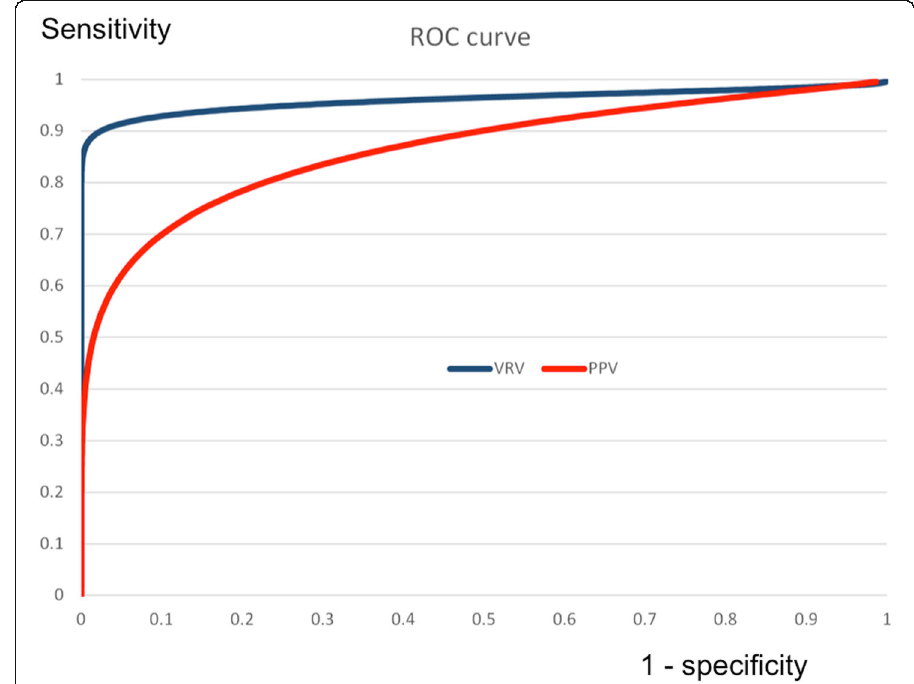
Fig. 5 AUC curves for VRV (0.96) and PPV (0.85) for prediction of fluid responsiveness. AUC area under curve, VRV venous return variation index, PPV pulse pressure